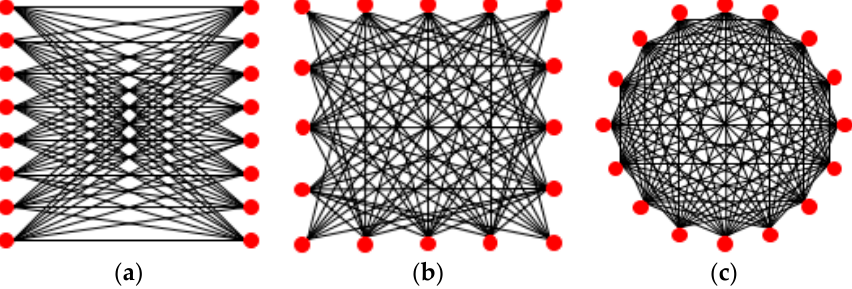
Figure 2. Three common iterative reconstruction methods: ( a ) Crosshole; ( b ) Double-crosshole; ( c ) Fan-beam.